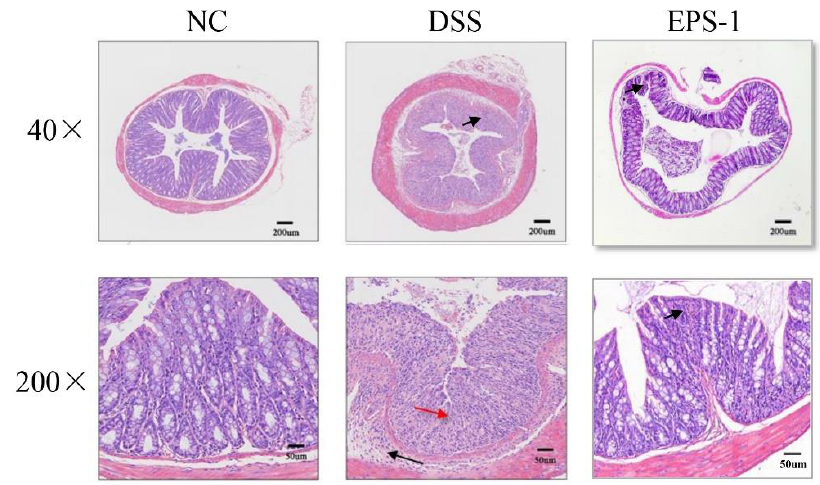
Figure 2. Effect of EPS-1 administration on the mouse colon histological changes (Representative hematoxylin and eosin staining).